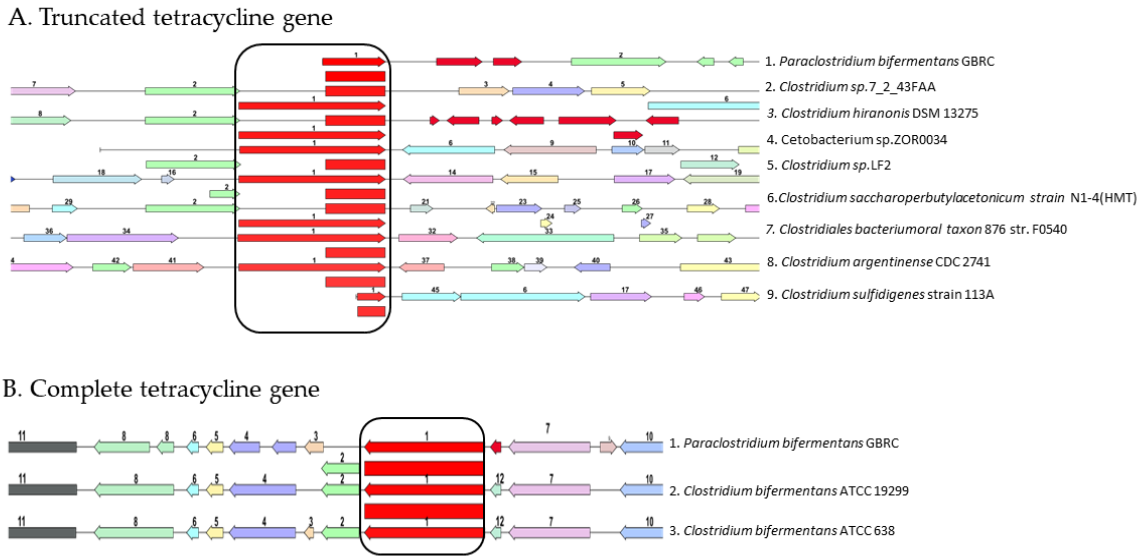
Figure 6. ( A ) Comparison of the truncated gene (1) TetM/TetW/TetO/TetS family tetracycline resistance ribosomal protection protein with different genera; ( B ) comparison of full gene (red colored) (1) TetM/TetW/TetO/TetS tetracycline family resistance ribosomal protection protein with different bacteria.